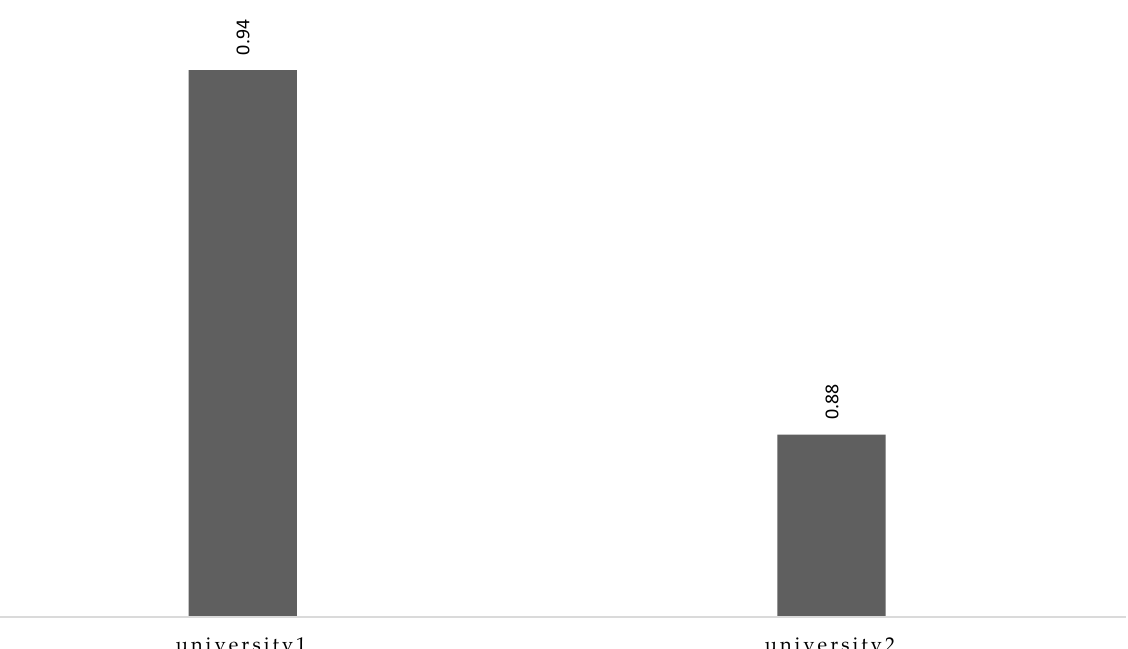
Figure 8. Graphical representations of the accuracy of ID2SBVR generating SBVR.